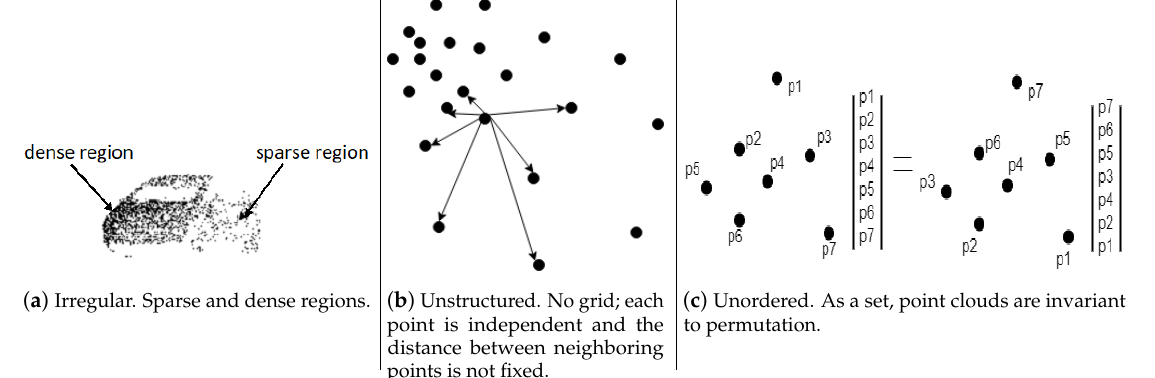
Figure 2. Challenges of point cloud data.